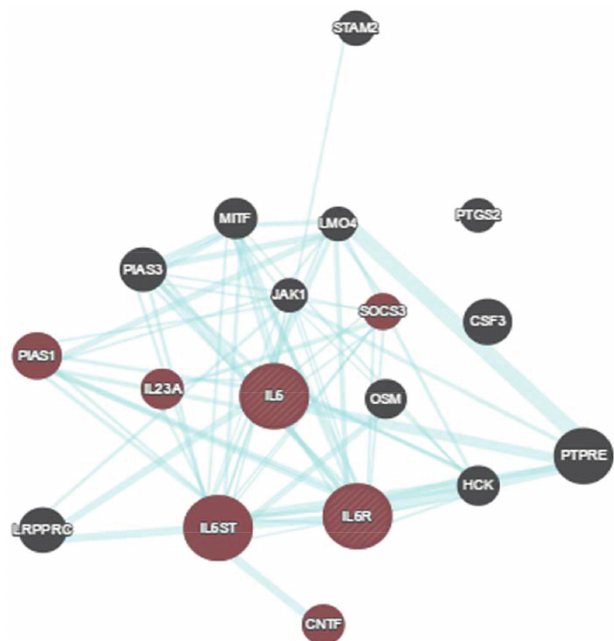
FIGURE 1 - Protein sub networks of IL-6R with other important proteins involved in